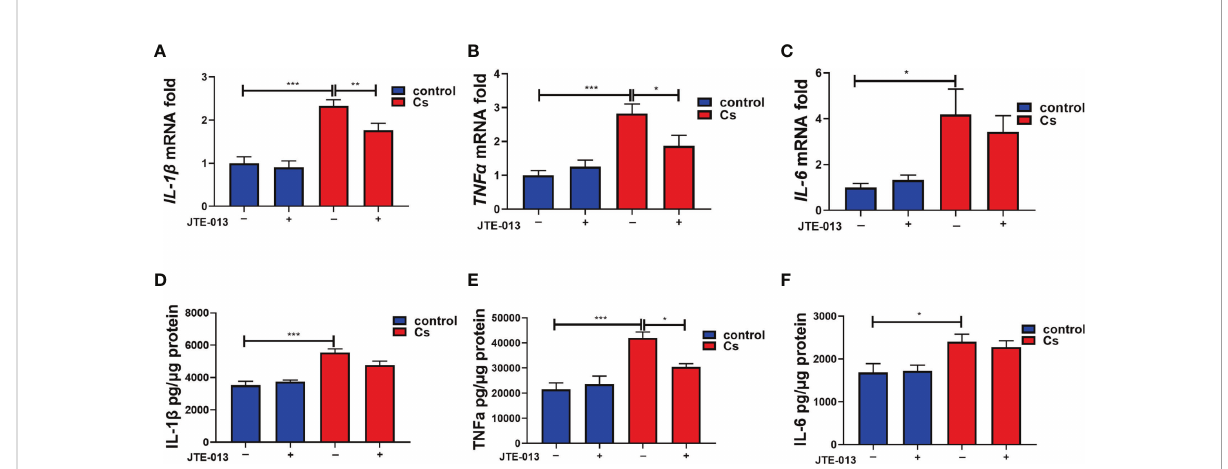
FIGURE 7 The inhibition of S1PR2 decreased the production of the pro-in fl ammatory cytokines after C. sinensis infection. (A – C) Measurement of the pro- in fl ammatory cytokines IL-1 b , TNF a , and IL-6 the relative mRNA expression in hepatobiliary tissue of control and C. sinensis -infected mice. (D-F) Measurement of the pro-in fl ammatory cytokines IL-1 b , TNF a , and IL-6 by ELISA in hepatobiliary tissue homogenate of control and C. sinensis -infected mice. Compared with indicated groups, * P <0.05, ** P <0.01, *** P